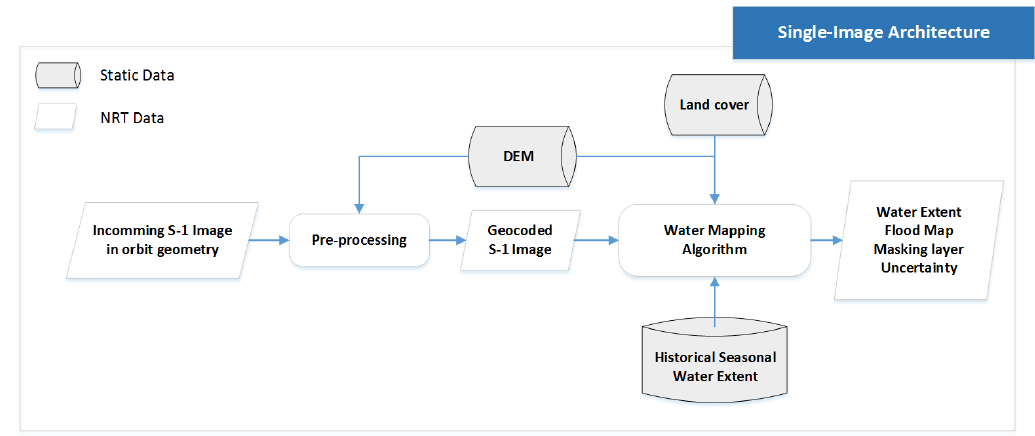
Figure 2. Single-image processing architecture for global flood monitoring using Sentinel-1 SAR image data.